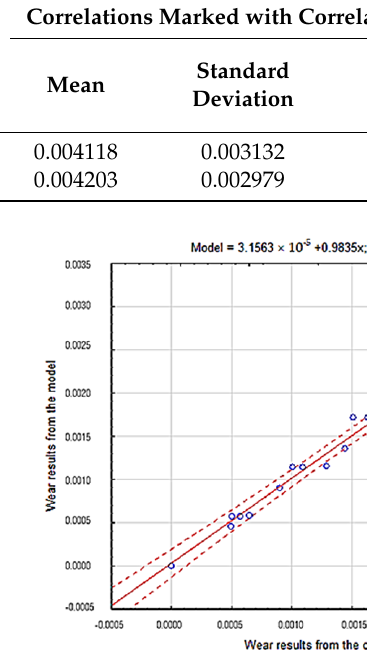
Table 6. Results of correlation analysis for the group of tested steels in heavy soil.